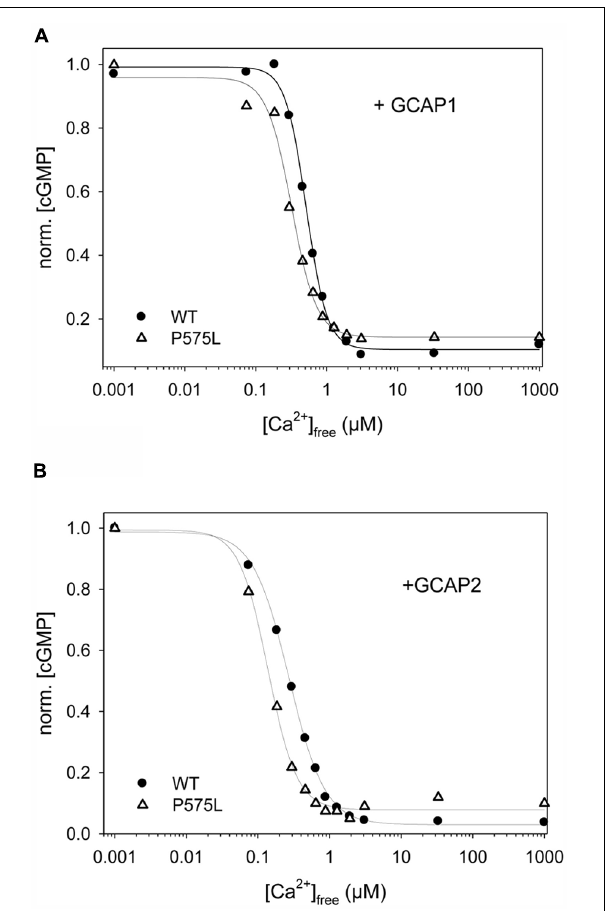
FIGURE 4 | Ca 2 + -sensitive activity profiles ofWT and ROS-GC1 mutant P575L. Guanylate cyclase activities were measured as a function of free [Ca 2 + ] for samples as indicated (A) WT or P575L, in the presence of 10 μ M GCAP1. (B) WT or P575L, in the presence of 10 μ M GCAP2. Incubation time was 30 min. Activities are normalized to allow comparison of IC 50 values ([Ca 2 + ] free at which activity is halfmaximal). Data are representative of three to four sets of incubations.